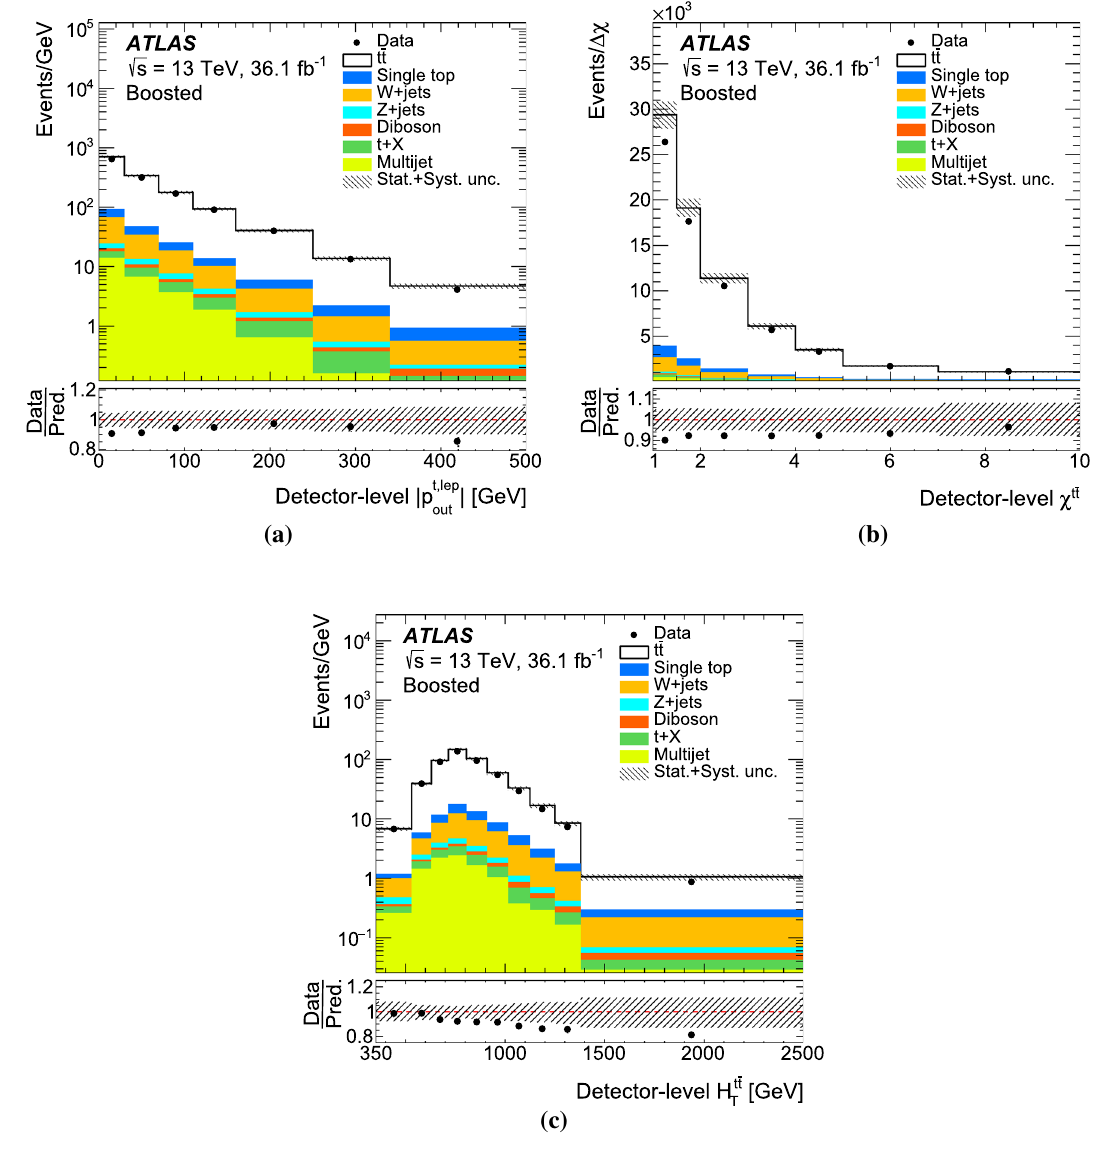
Fig. 12 Distributions of observables in the (cid:3) + jets channel in the tistical and systematic uncertainties (described in Sect. 9) in the total prediction, excluding systematic uncertainties related to the modelling boosted topology at detector-level: a absolute value of the out-of-plane , lep | , b production angle χ t ¯ t and c scalar sum of the of the t ¯ t events. Underflow and overflow events, if any, are included in momentum | p t out the first and last bins. The lower panel shows the ratio of the data to the transverse momenta of the hadronic and leptonic top quarks H t ¯ t . Data T total distributions are compared with predictions, using Powheg + Pythia8 as the t ¯ t signal model.The hatched area represents the combined sta-